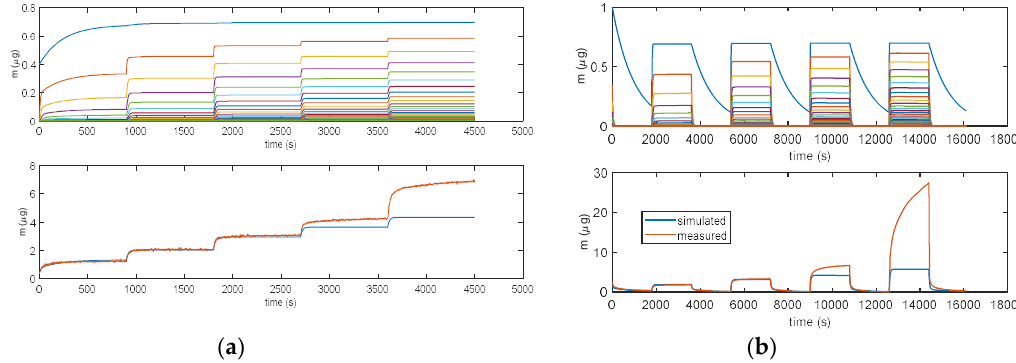
Figure 11. Results obtained with model in Equation (3). ( a ) Measurement protocols: starting from dry air, RH is increased with steps of 15% (RH = 15%, 30%, 45%, 60%, and 75%) each 15 min (900 s). ( b ) Measurement protocol: RH = 0% (30 min), RH = 25% (30 min), RH = 0% (30 min), RH = 50% (30 min), RH = 0% (30 min), RH = 75% (30 min), RH = 0% (30 min), RH = 100% (30 min), and RH = 0% (30 min). Lower plots: total adsorbed mass; blue lines: adsorbed mass predicted by the model; and red lines: measured adsorbed water mass obtained exploiting the cantilever sensor (deposition of 35 μ g of TiO 2 nanoparticles). Upper plots: mass adsorbed in the different layers predicted by the models. Blue lines—first layer; other colors—upper layers.